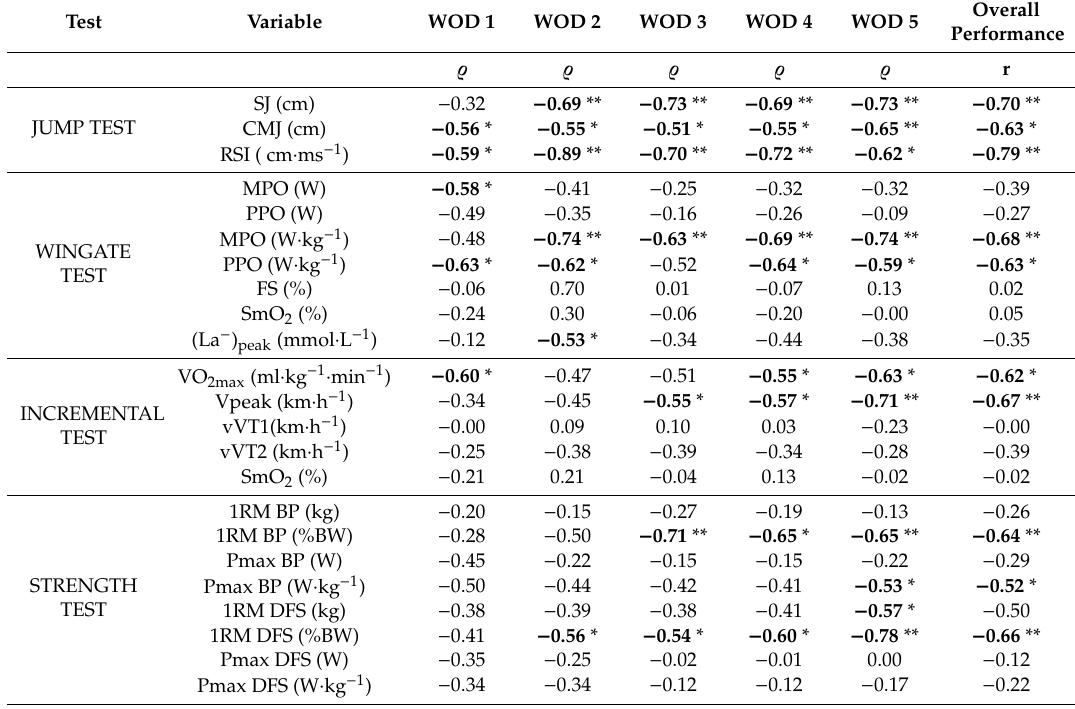
Table 4. Relationship between the di ff erent physiological variables and the position (i.e., ranking within the group) for each workout of the day and overall CrossFit